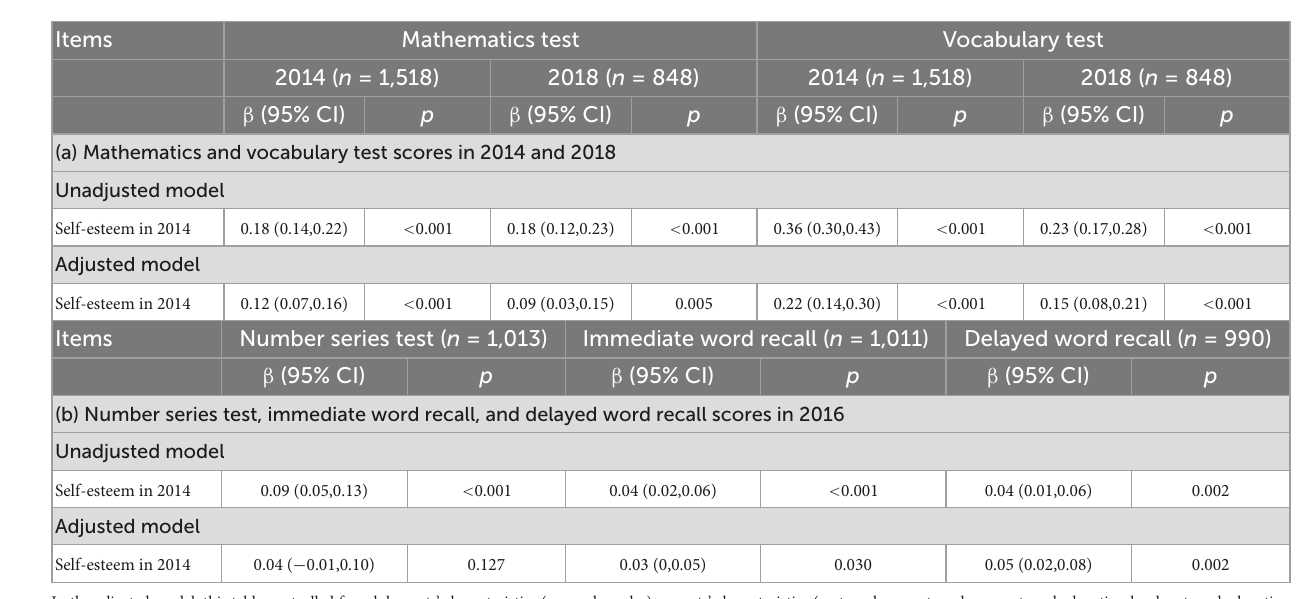
TABLE 2 The association of self-esteem in 2014 with cognitive test scores in 2014, 2016, and